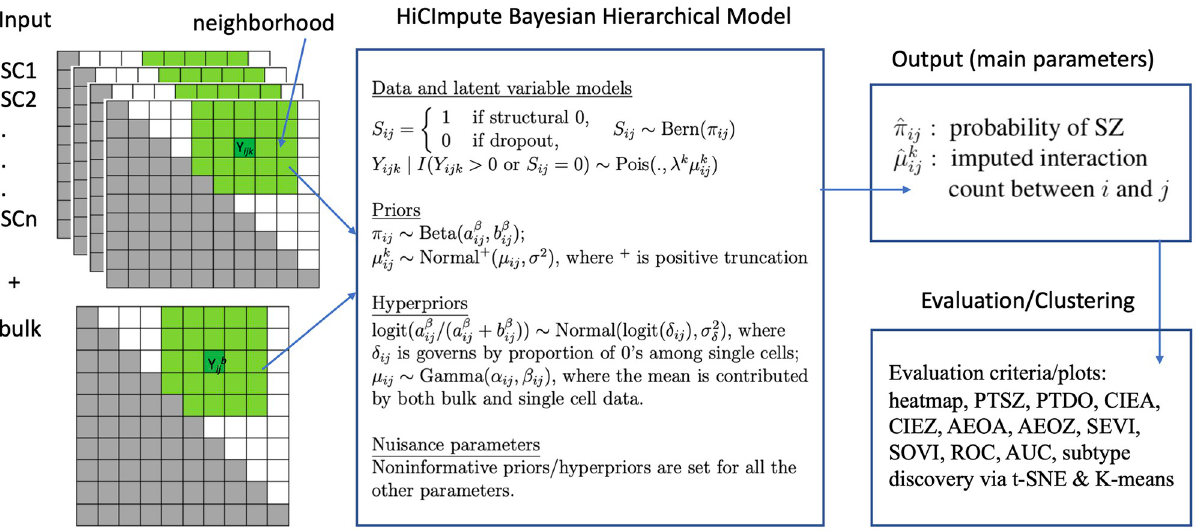
Fig 1. Schematic of the HiCImpute algorithm. Each green region on the left denotes the neighborhood. The indicator variable S observed zero at the ( i , j ) position is a structural zero or not. The λ k is related to the sequencing depth of single cell k and acts as a normalizing factor. Finally, the intensity parameter m k is assumed to follow a common distribution across all similar single cells; shrinkage estimation with information ij from neighborhoods and bulk data will be obtained, which provides accommodations for potential overdispersion. PTSZ (proportion of true structural zeros correctly identified), PTDO (proportion of true dropouts correctly identified), AEOA (absolute error of all observed), AEOZ (absolute error of observed zeros), CIEA (correlation between imputed and expected for all observed), CIEZ (correlation between imputed and expected for observed zeros), SEVI (scatterplot of expected versus imputed), and SOVI (scatterplot of observed versus imputed), ROC (receiver operational characteristics), AUC (area under the